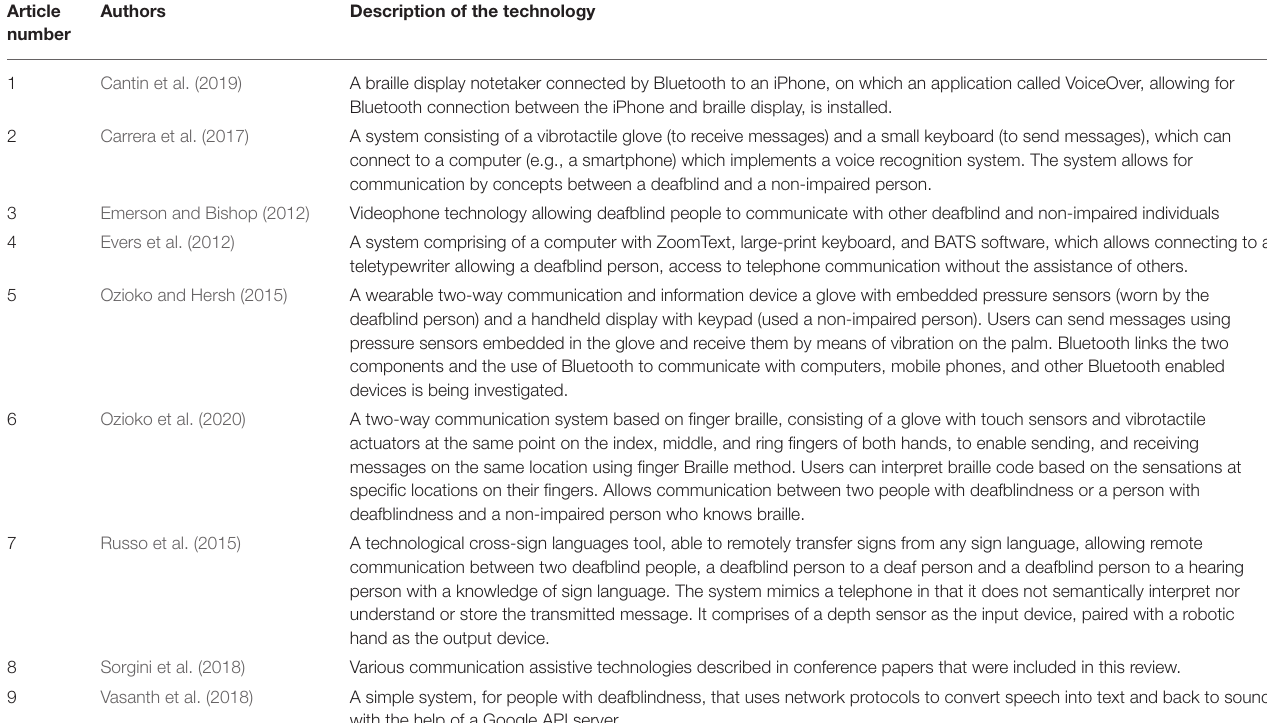
TABLE 3 | Description of the communication assistive